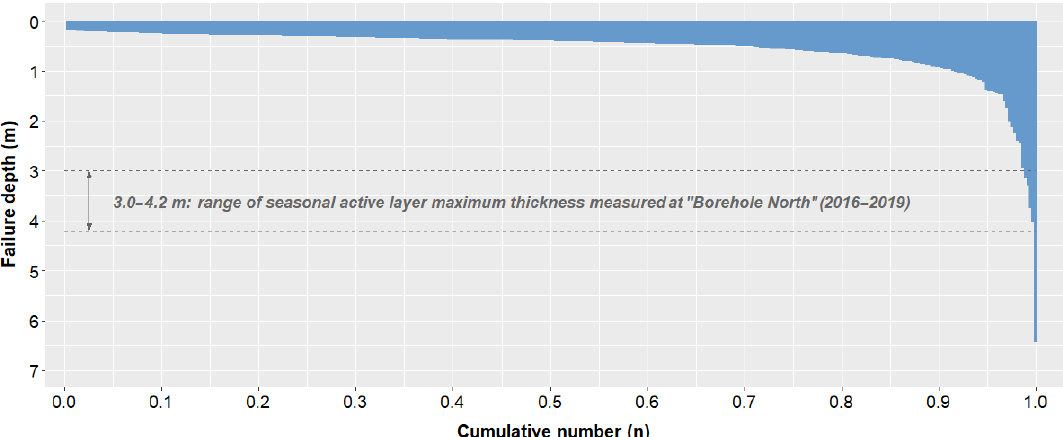
Figure 13. Failure depths for all registered rockfalls ( n = 374). More than 90% of all rockfalls failed within less than 1m from the surface. The seasonal active layer maximum thickness measured at T-BN (30m deep borehole at KN) ranged from 3.0 to 4.2m